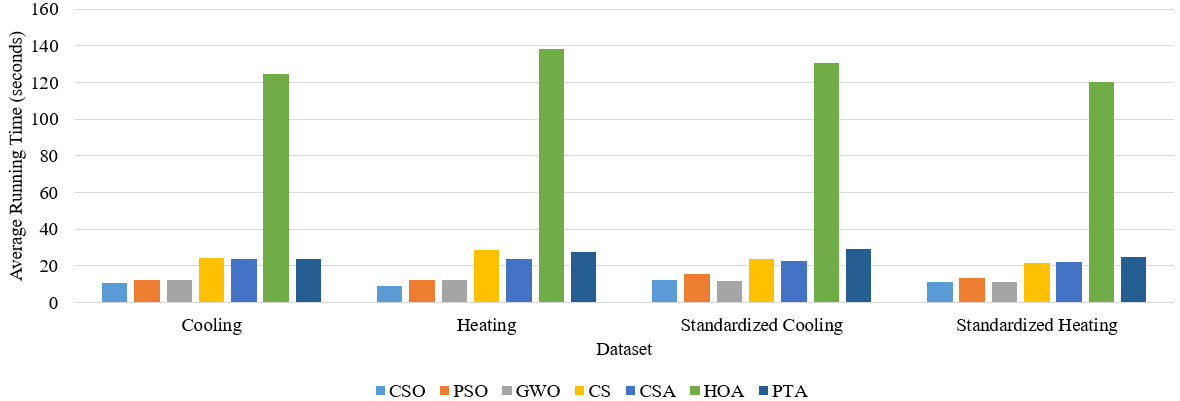
Figure 15. Comparison of the PTA Ensemble Average Running Time with the Average Time of Other Nature-Inspired Algorithm-Based Ensembles. Nature-Inspired Algorithm-Based